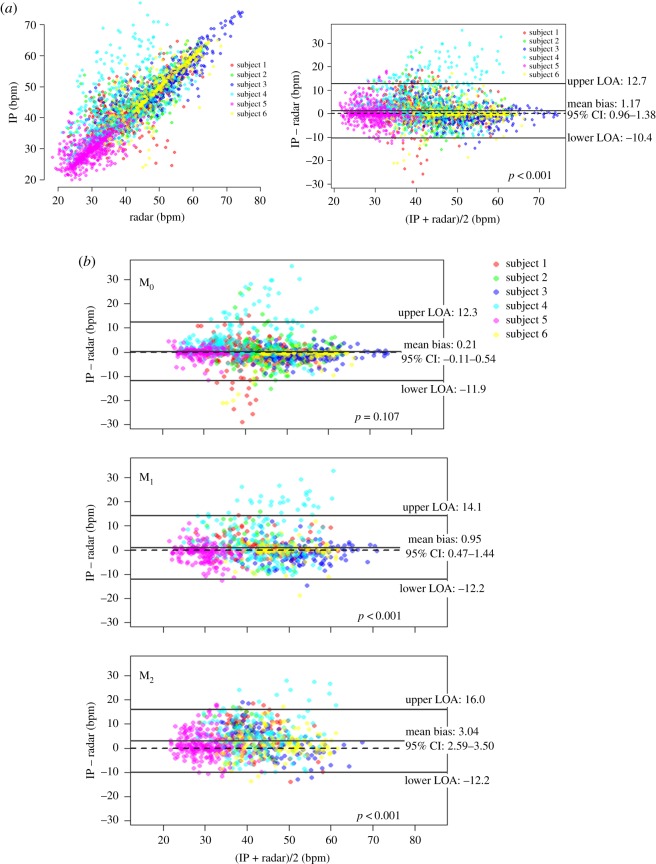
Comparison of RR (bpm) measured with the IR-UWB radar system and IP in all six neonates. (a) Scatterplot and Bland–Altman plot between the IR-UWB radar measurements and the IP measurements. A total of 2974 samples were collected from six subjects (average 495.7 ± 137.4 bpm). The mean bias was 1.17 bpm and significant in a one-sample t-test. The LOA was −10.4 to 12.7 bpm. (b) Bland–Altman plots between the IR-UWB radar measurements and the IP measurements according to the movement levels. The mean bias levels and the widths of LOA increased significantly as the movement levels increased. The mean bias was not significant in M0, but in M1 and M2, the mean biases were significant and approximately 1.0 and 3.0 bpm, respectively.